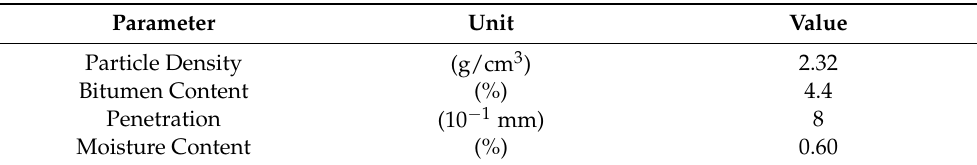
Table 3. Emulsion and binder characteristics.